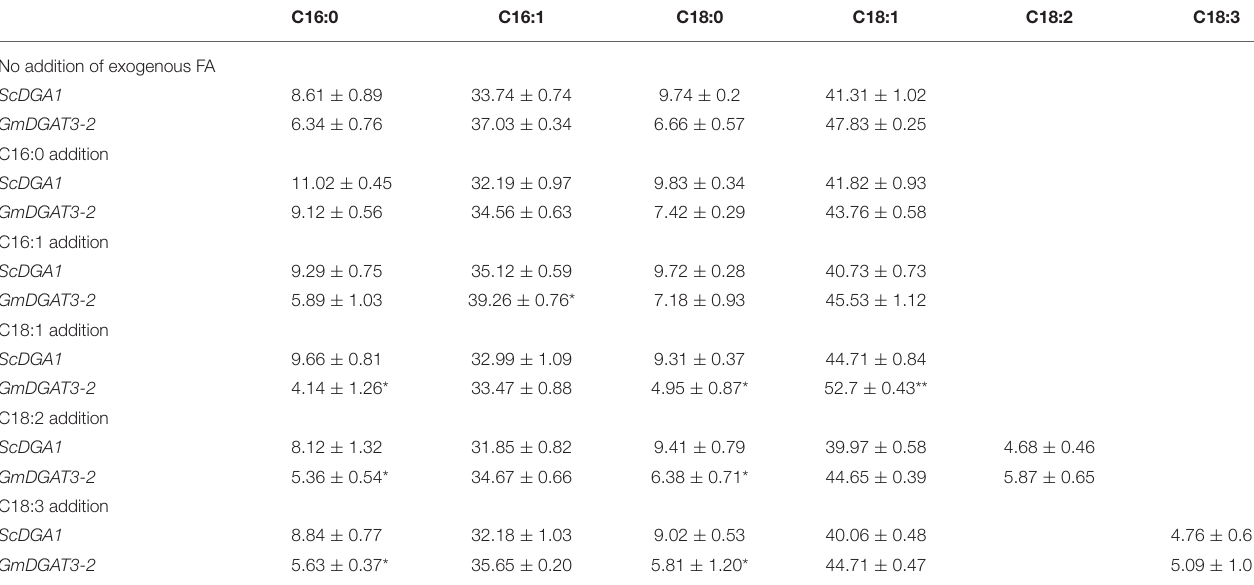
TABLE 1 | Fatty acid profiles of H1246 yeast expressing GmDGAT3-2 and the controls cultured in the medium supplemented with exogenous fatty